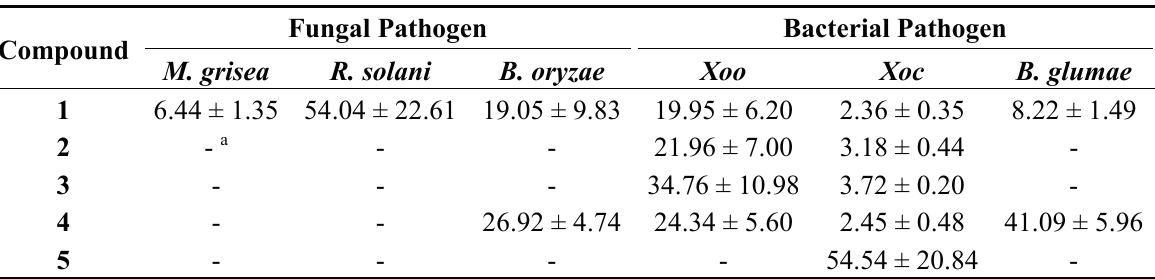
Table 1. IC 50 ( μ g/mL) of the phenolic compounds isolated from UV-treated rice leaves to fungal and bacterial pathogens.